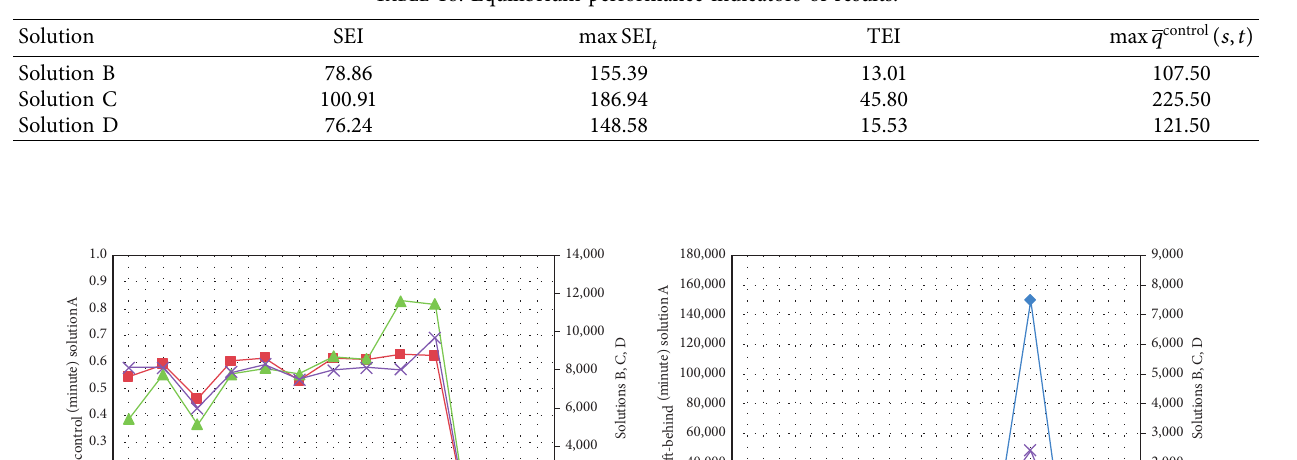
Table 18: Equilibrium performance indicators of results.